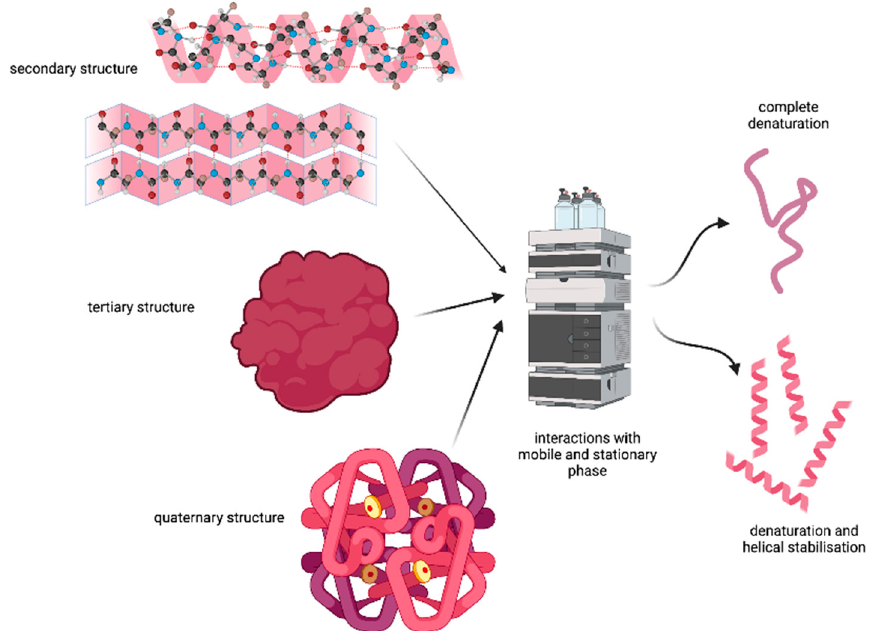
Figure 3. Denaturation of peptides and proteins during LC separation. (Created with Bioren- der.com .)